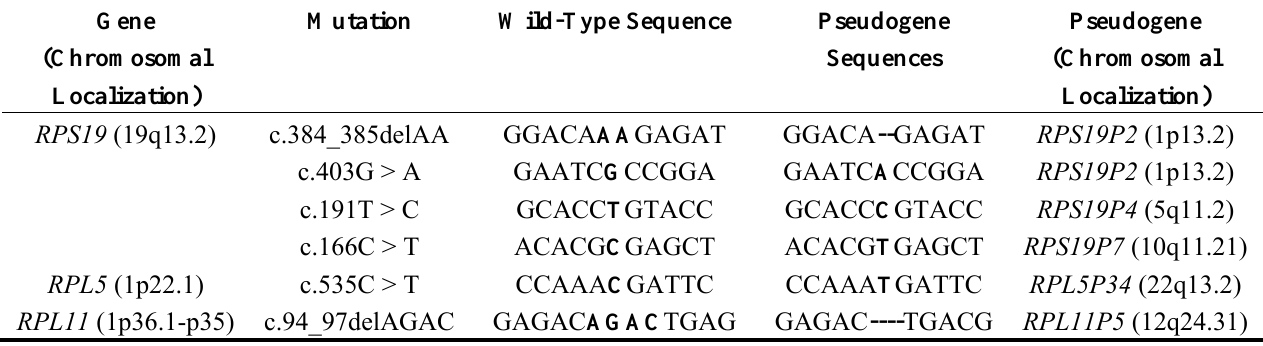
Table 1. Six ribosomal protein (RP) mutations found to coincide with pseudogene